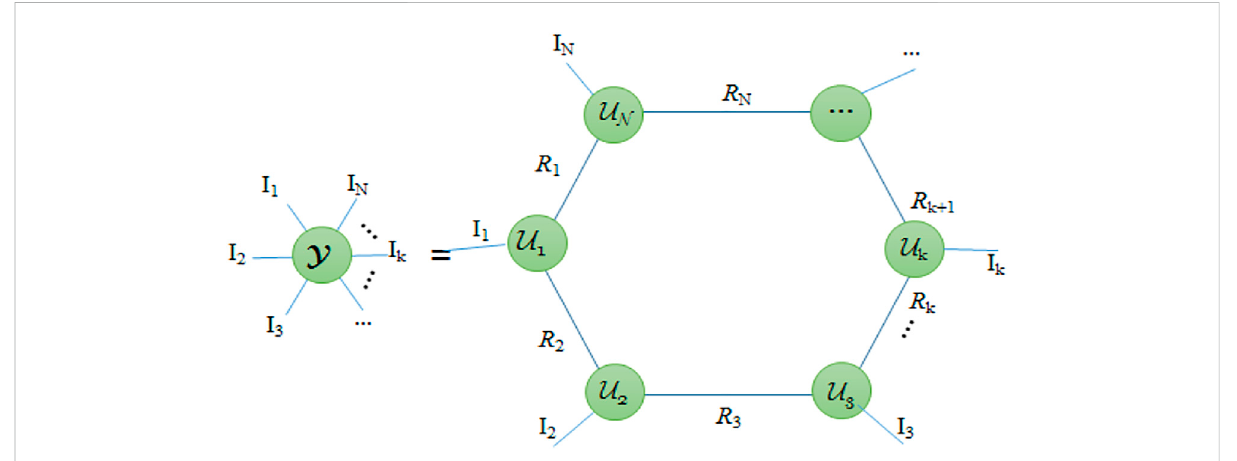
FIGURE 1 Illustration of TR representation of an Nth-order tensor Y ∈ R I 1 × I 2 ...× I N